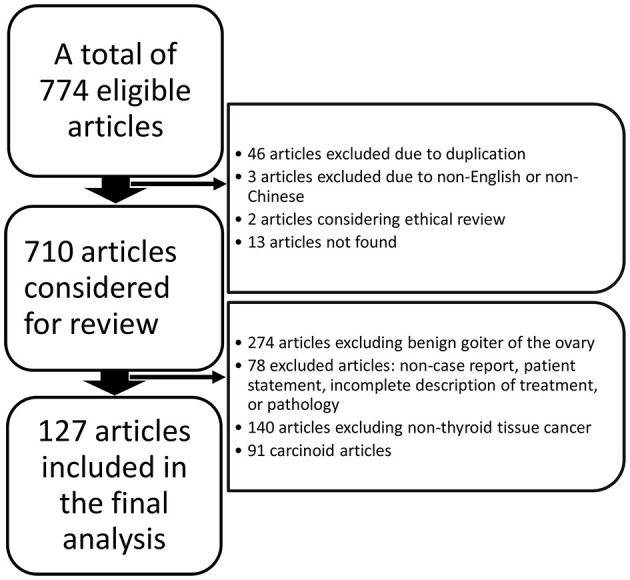
Literature review inclusion process.